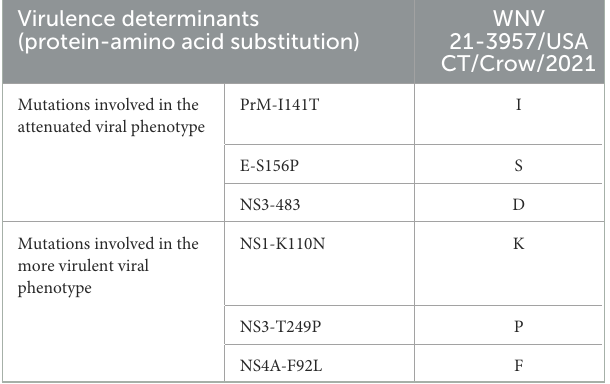
TABLE 3 Amino acid substitutions of WNV 21-3782/USA CT/Alpaca/2021 virus in virulence determinants in the WNV genome found in mammalian host.